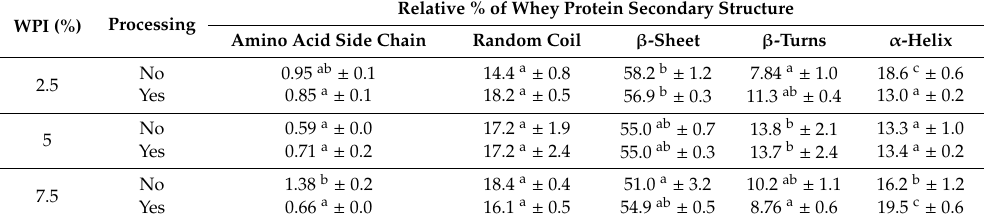
Table 2. FTIR Analysis of the secondary structure of whey protein in CD samples before and after the OC processing.